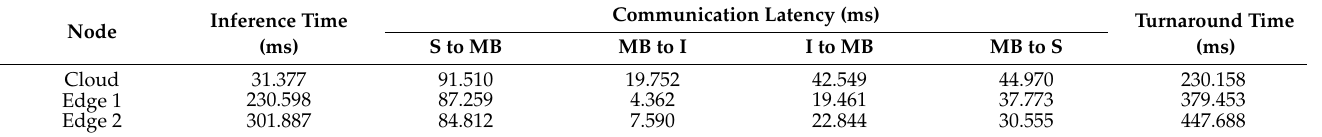
Table 9. Prediction: Time and